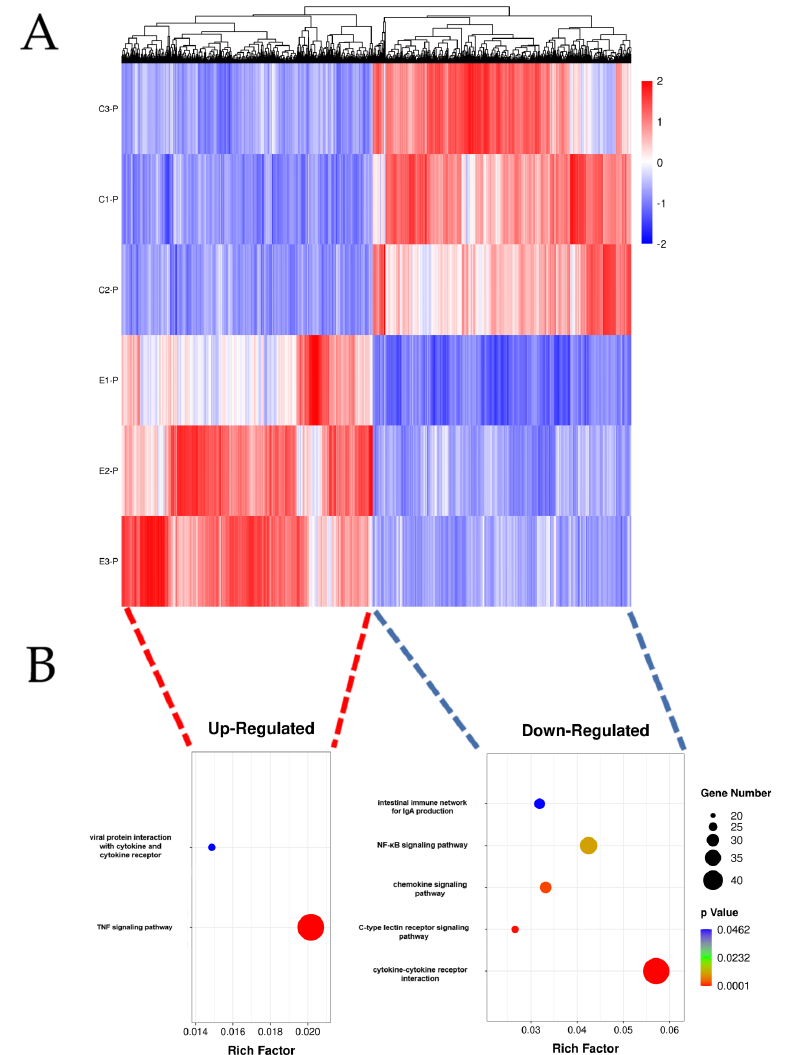
Figure 5. Analysis of DEGs and pathways derived from mouse spleens infected with P. multocida . ( A ) Heatmap of DEGs. Colors from blue (low) to red (high) represent DEG expression level. Each row in the map represents a sample, and each column represents a gene. ( B ) Kyoto Encyclopedia of Genes and Genomes (KEGG) pathway analysis of up- and down-regulated DEGs. Dot size represents the number of genes. The rich factor indicates the ratio between the number of genes annotated for a KEGG pathway and the number of all genes annotated for the KEGG